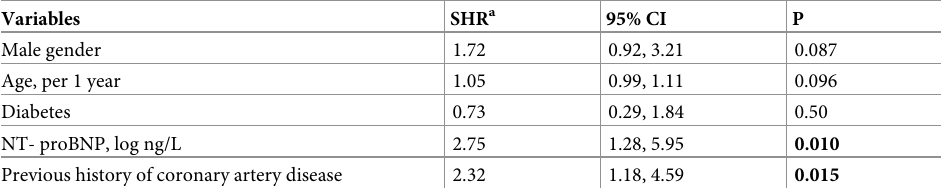
Previous history of coronary artery